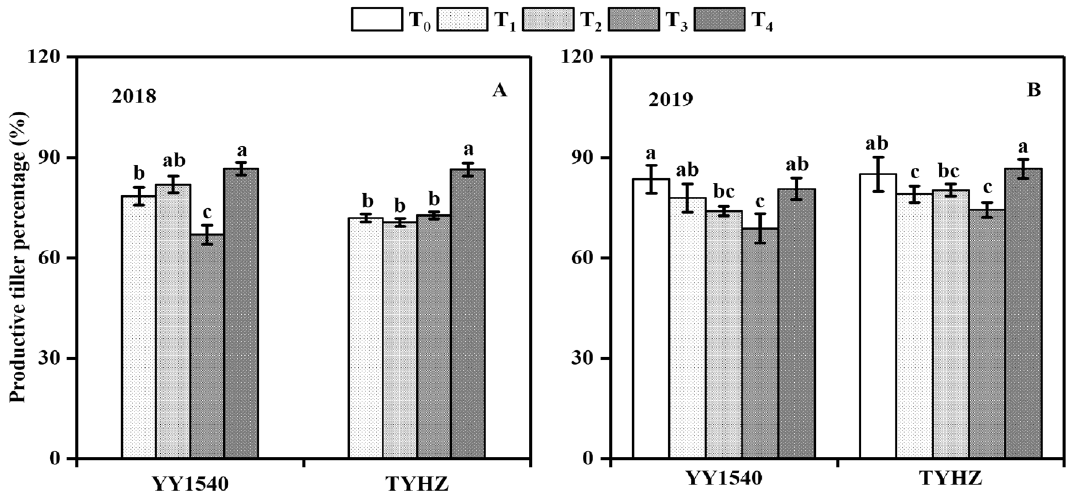
Figure 2. Productive tiller percentage of indica – japonica hybrid rice (‘Yongyou1540’, YY1540) and indica hybrid rice (‘Tianyouhuazhan’, TYHZ) under four nitrogen fertilization treatments. ( A ) 2018; ( B ) 2019. Bars with different lower-case letters are significantly different at the 0.05 probability level among treatments. T 0 no-nitrogen application control, T 1 traditional nitrogen application, T 2 single-dose controlled-release nitrogen application, T machine transplanting and 30% as topdressing applied at the panicle initiation